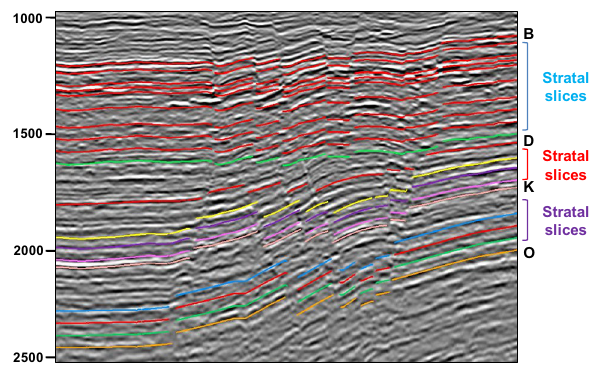
Fig. 2 Interpreted horizons and the calculated horizons